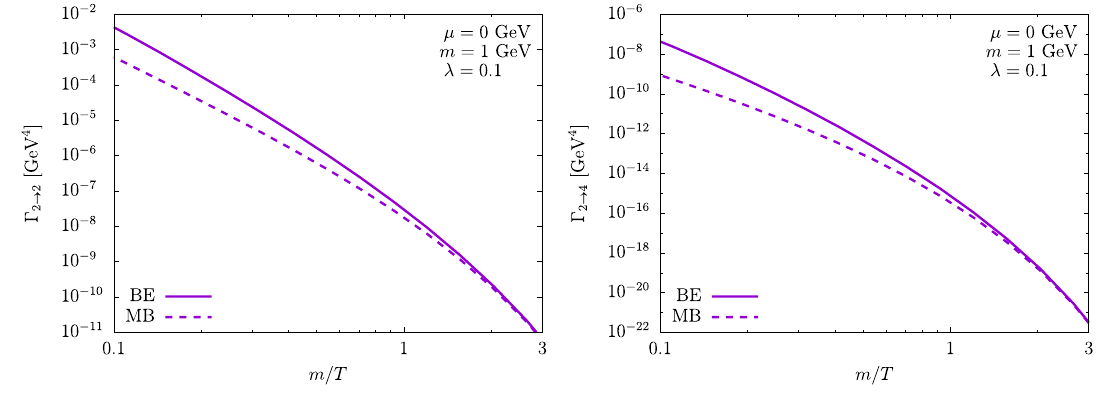
Figure 4 . Reaction rates with Bose-Einstein statistics versus those with Maxwell-Boltzmann statis-